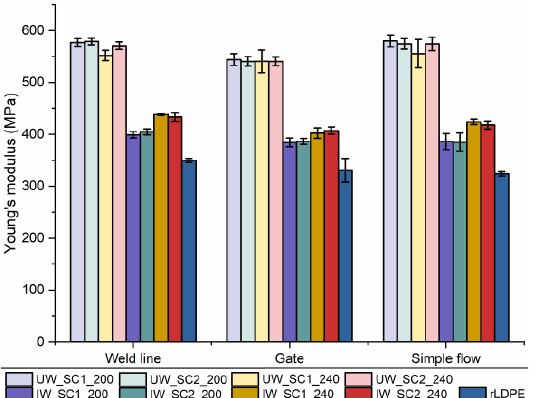
Figure 5. Young’s modulus of the samples at different regions in the IM frame.